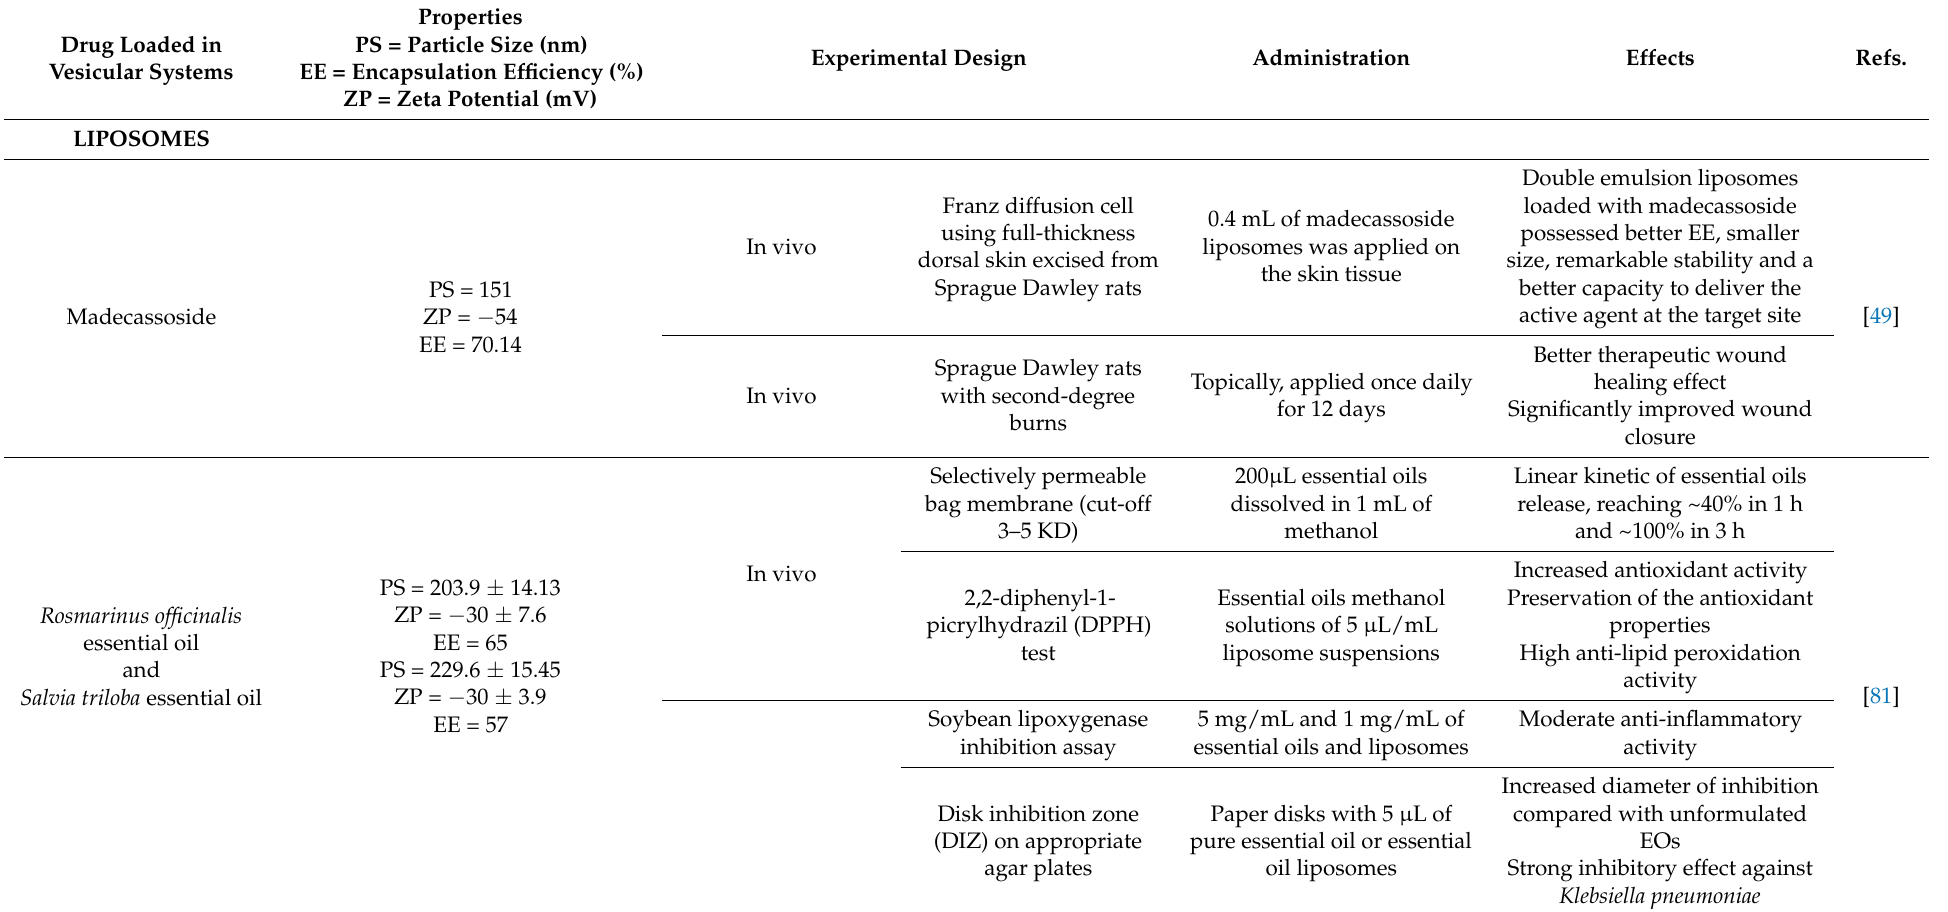
Table 1. Applications of vesicular systems in wound